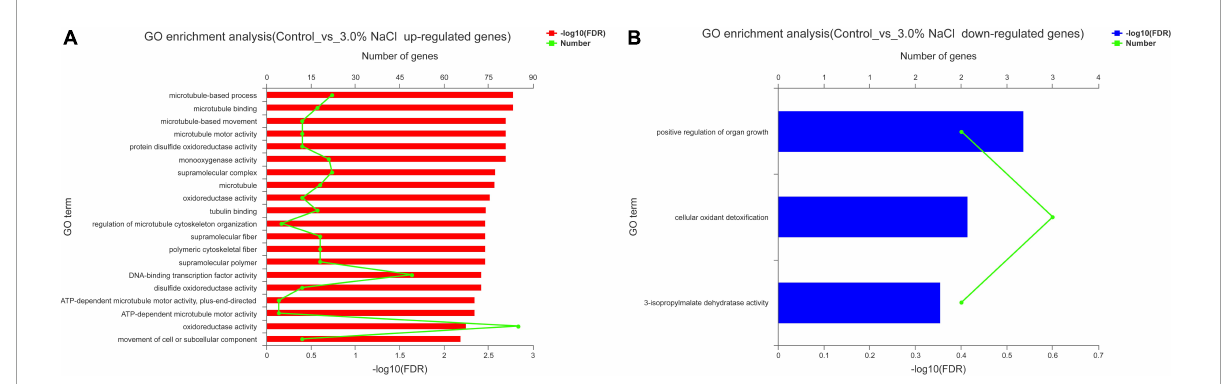
FIGURE6 GO enrichment analysis of the DEGs in S. caseolaris under 3.0% NaCl treatment. (A) Upregulated genes, (B) downregulated genes.